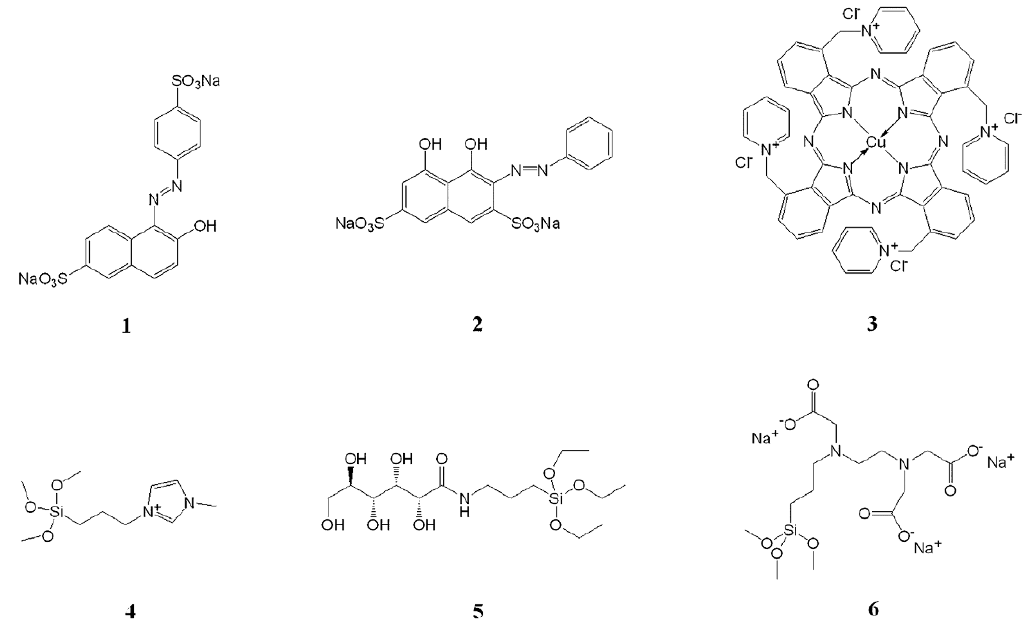
Figure 5. Dyes and capping reagents used in the